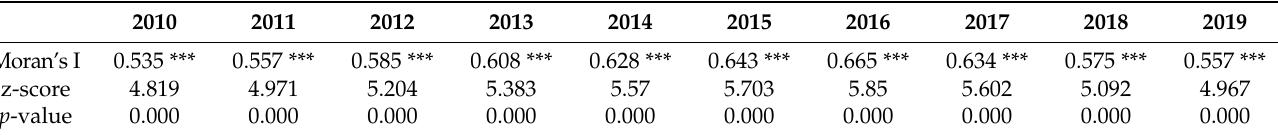
Table 5. Global Moran Index of Rural Resilience